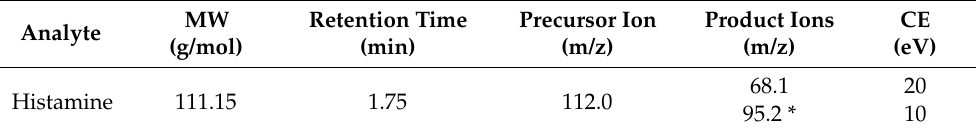
Table 1. Mass spectrometric parameters for the determination of histamine using an electrospray interface (ESI) in positive ionization mode. MW Analyte (g/mol)